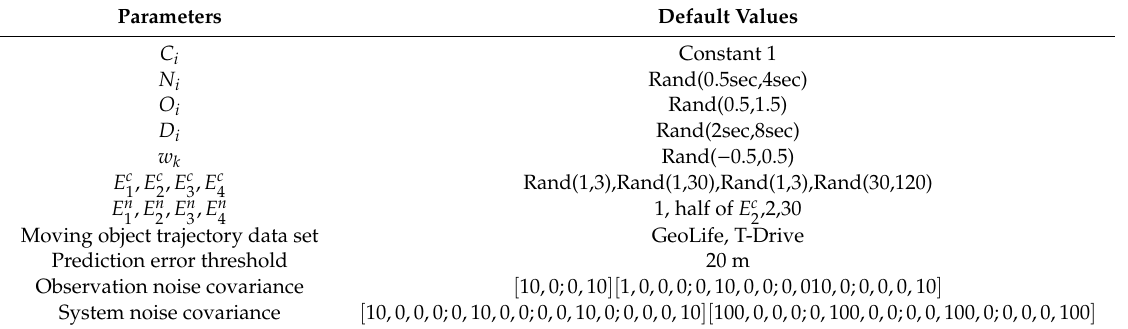
Table 2. Application parameter setting in the simulation.